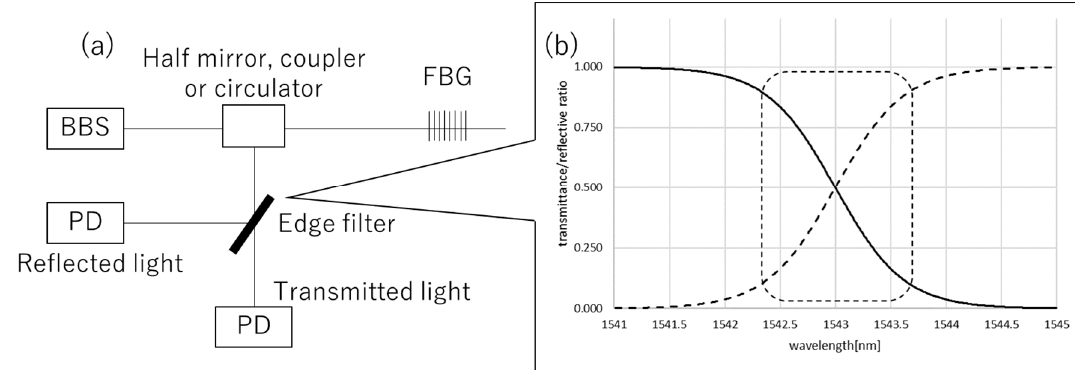
Figure 2. ( a ) Typical setup of the edge filter-based FBG interrogation. The light emitted from a broad band light source (BBS) enters the FBG and only the light of the Bragg wavelength is reflected. The reflected light enters the edge filter and is divided into the reflected and transmitted light, whose ratio depends on the wavelength, as in ( b ). These lights are observed by photo-detectors (PDs). ( b ) Conceptual diagram of the wavelength dependence of the transmission / reflection ratio of the edge filter. The dashed square indicates the slope used for FBG demodulation. The solid and dashed lines indicate the transmittance and reflectance ratio, respectively. The FBG wavelength is set in the dashed square range, in which the wavelength dependence could approximate a linear function.